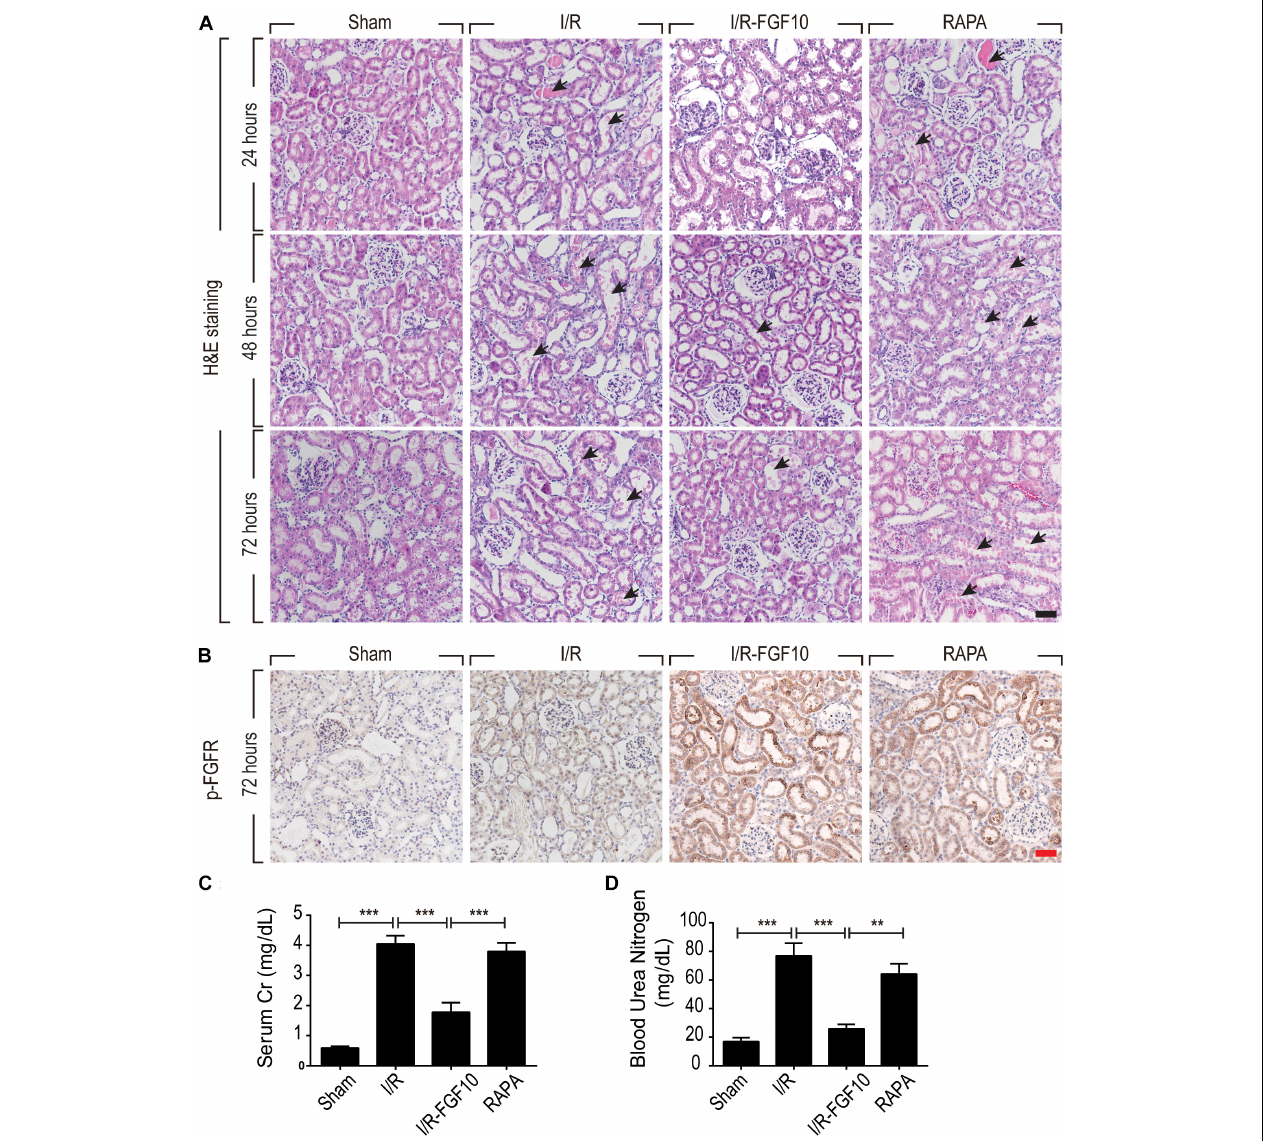
FIGURE 1 | FGF10 protects against renal histological and function damage after I/R injury. (A) Histological changes of kidneys detected by H&E staining at 24, 48, and 72 h, respectively, after reperfusion. Animals were randomly assigned into 4 groups: namely, Sham group, I/R group, I/R-FGF10 group and RAPA group. The details of operations and treatment animals received were described in the materials and methods. Arrows show intraluminal necrotic cells. Scale bars = 50 µ m. (B) IHC staining for p-FGFR in renal tissue sections of indicated groups. Scale bars = 50 µ m. (C,D) Determination of SCr and BUN levels in the above grouped rats at 2 days after reperfusion (mean ± SEM; n = 5). ∗∗ P < 0.01, ∗∗∗ P <